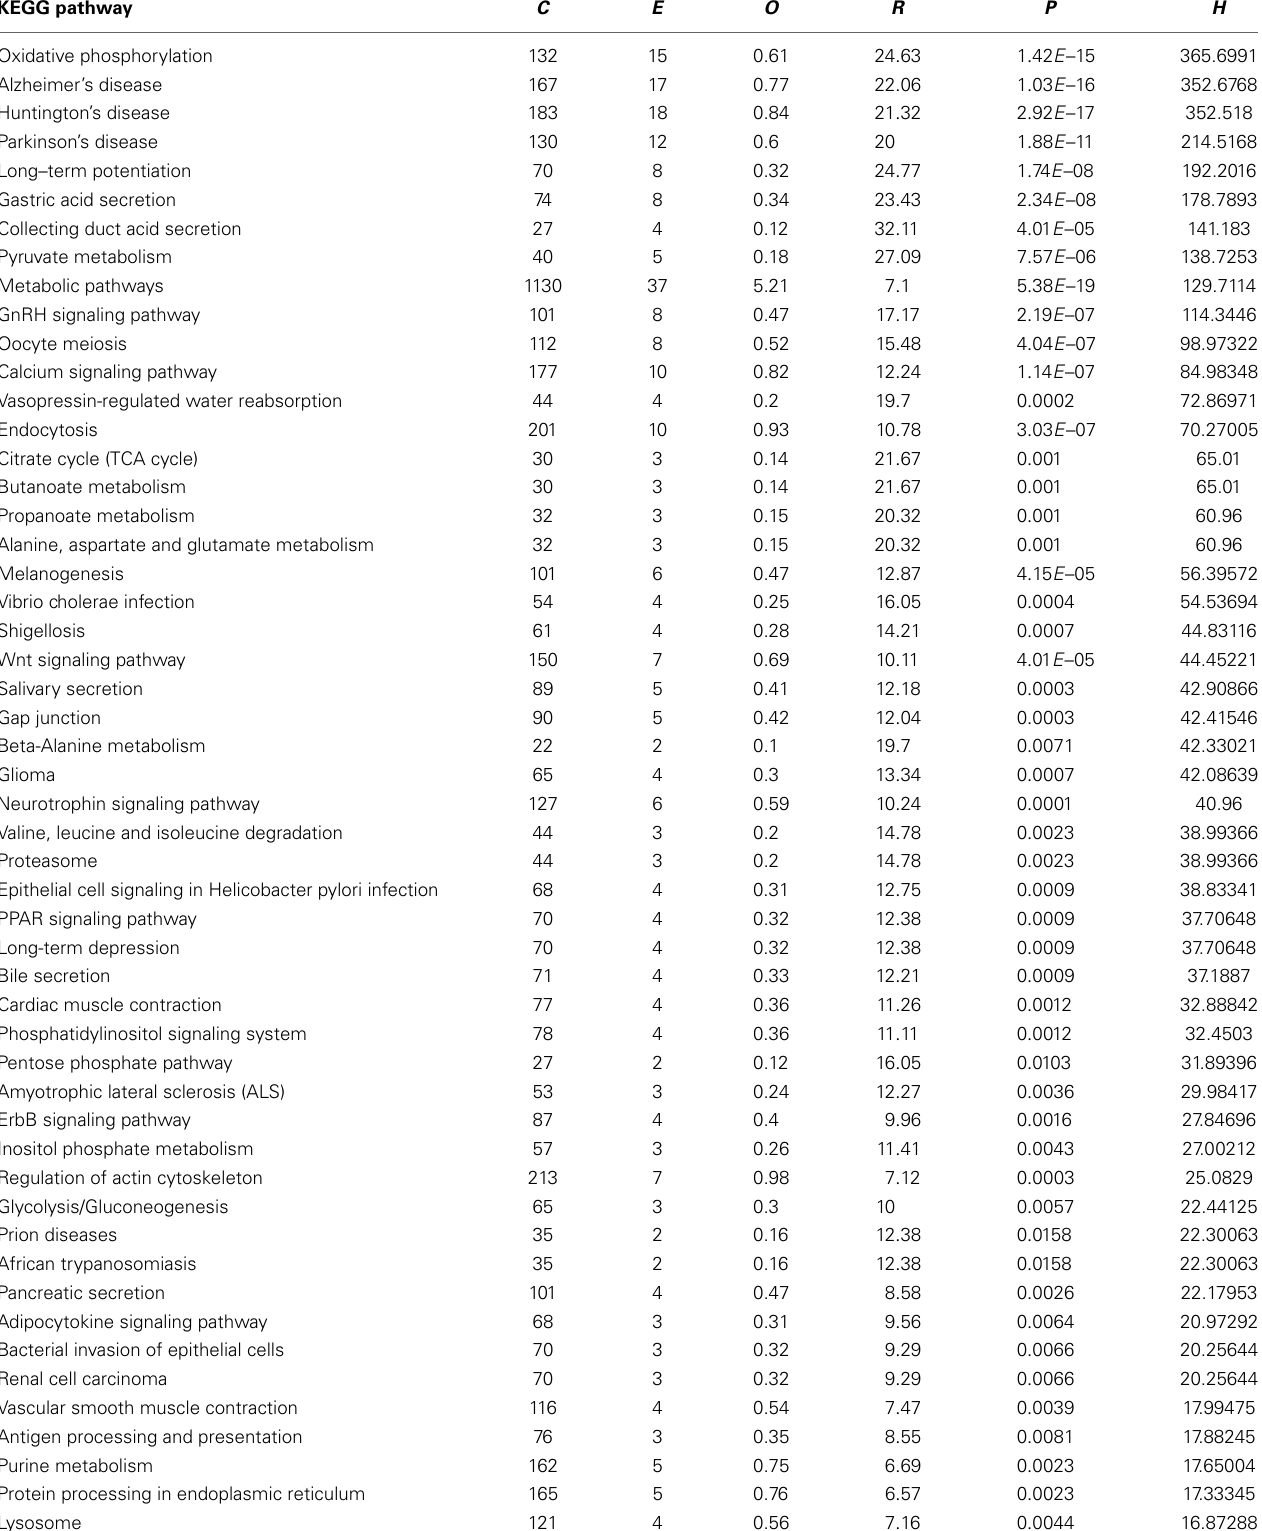
Table 4 | KEGG Pathway analysis for hippocampal proteins altered in BTBR mice compared to WT